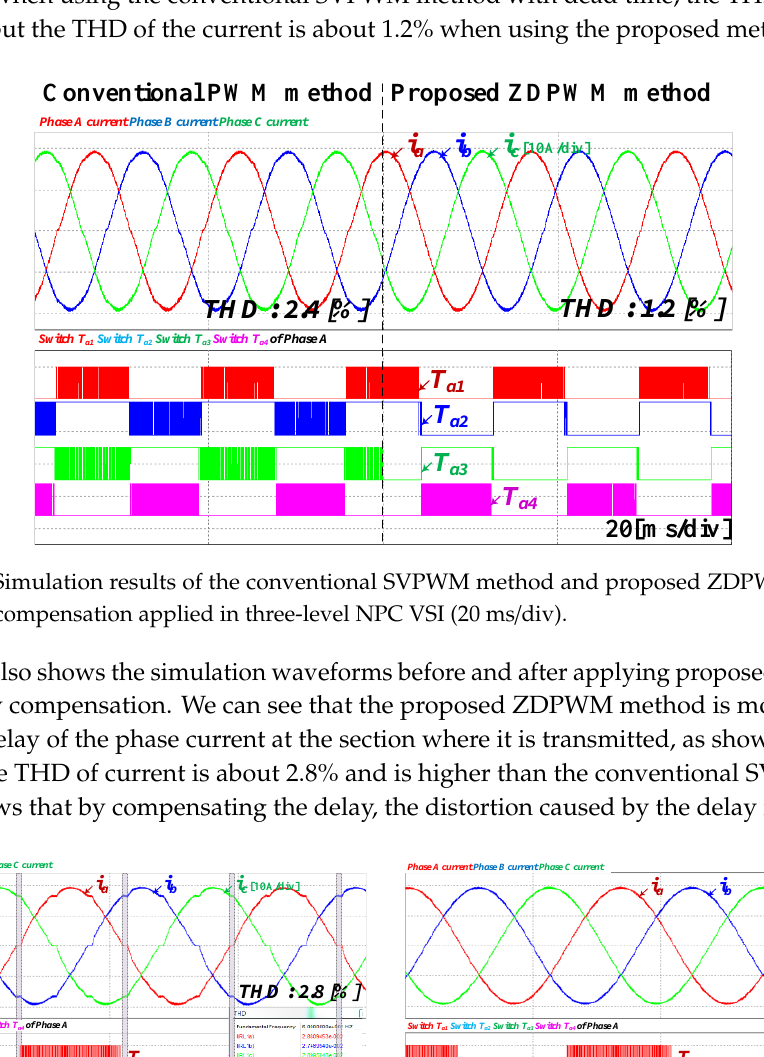
Figure 23. Simulation results of the real phase angle and compensated phase angle.